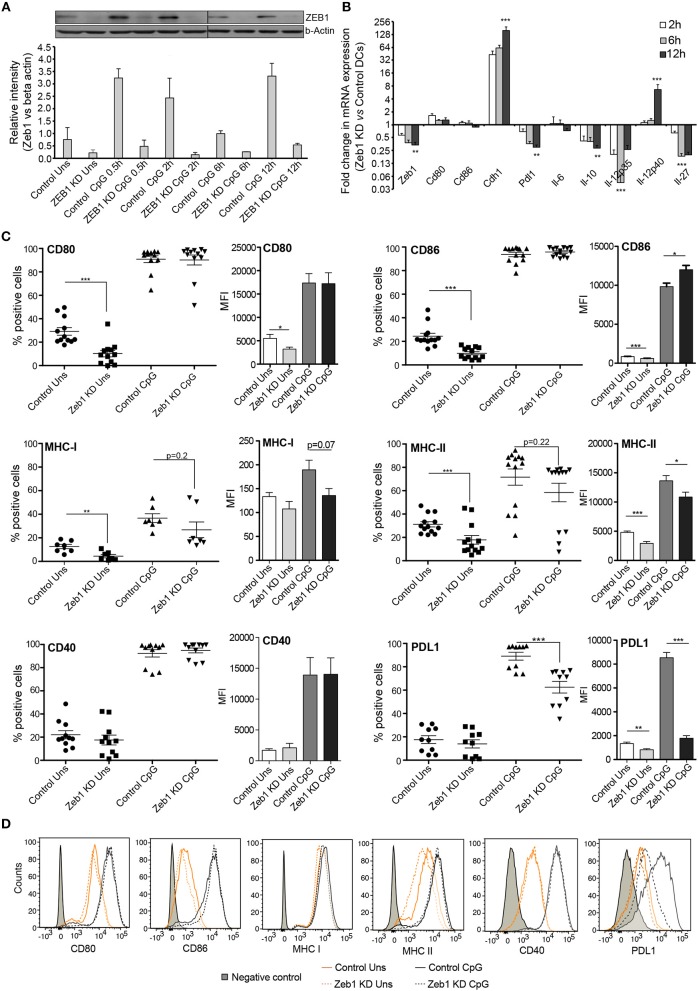
Zeb1 transcription factor KD suppresses activation and co-stimulation of CD8α+ cDC1 MutuDCs. (A) Western blot and its densitometric analysis showing the ZEB1 protein expression kinetics and its KD by shRNA at 0, 0.5, 2, 6, and 12 h after CpG activation in CD8α+ cDC1 DCs n = 2. (B) Bar-plot demonstrating the fold changes in the transcript expression of DC activation/co-stimulation markers and selected cytokine genes in Zeb1 KD DCs compared to control cells using qPCR n = 3. (C) Scatter-plots showing the percentage positive cells for cell-surface expression of activation and co-stimulatory markers CD80, CD86, MHC-I, MHC-II, CD40, and PDL1 on Zeb1 KD cDC1 MutuDCs compared to control cells before and after 12 h CpG activation. The corresponding panels with bar plots depict the Median Florescence Intensity (MFI) shifts for the respective genes n = 6–12. (D) Representative histogram plots demonstrating the MFI shift observed for the activation/co-stimulatory markers and cytokines. p-values are calculated using two tailed unpaired student's t-test, error bars represent SEM. * ≤ 0.05, ** ≤ 0.01, *** ≤ 0.001.